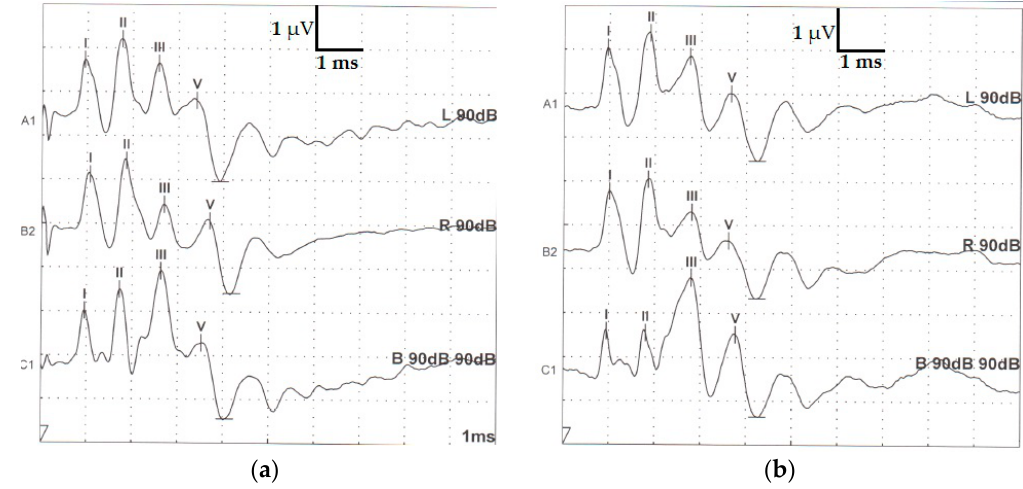
Figure 1. Typical morphology of two adult healthy raccoon dog brainstem auditory evoked responses recorded (( a ) individual 7 and ( b ) individual 9) after stimulation of the left ear (upper trace), right ear (middle trace) and binaural stimulation (bottom) under general anesthesia. (horizontal bar—ms; vertical bar μ V—microvolts).